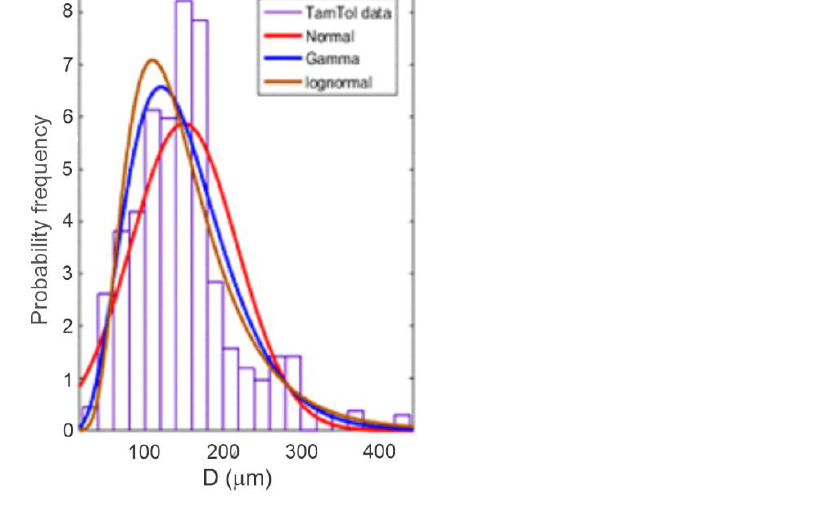
Figure 5. Frequency of diameters for the Usumacinta at t = 45 min after RAF experiments.